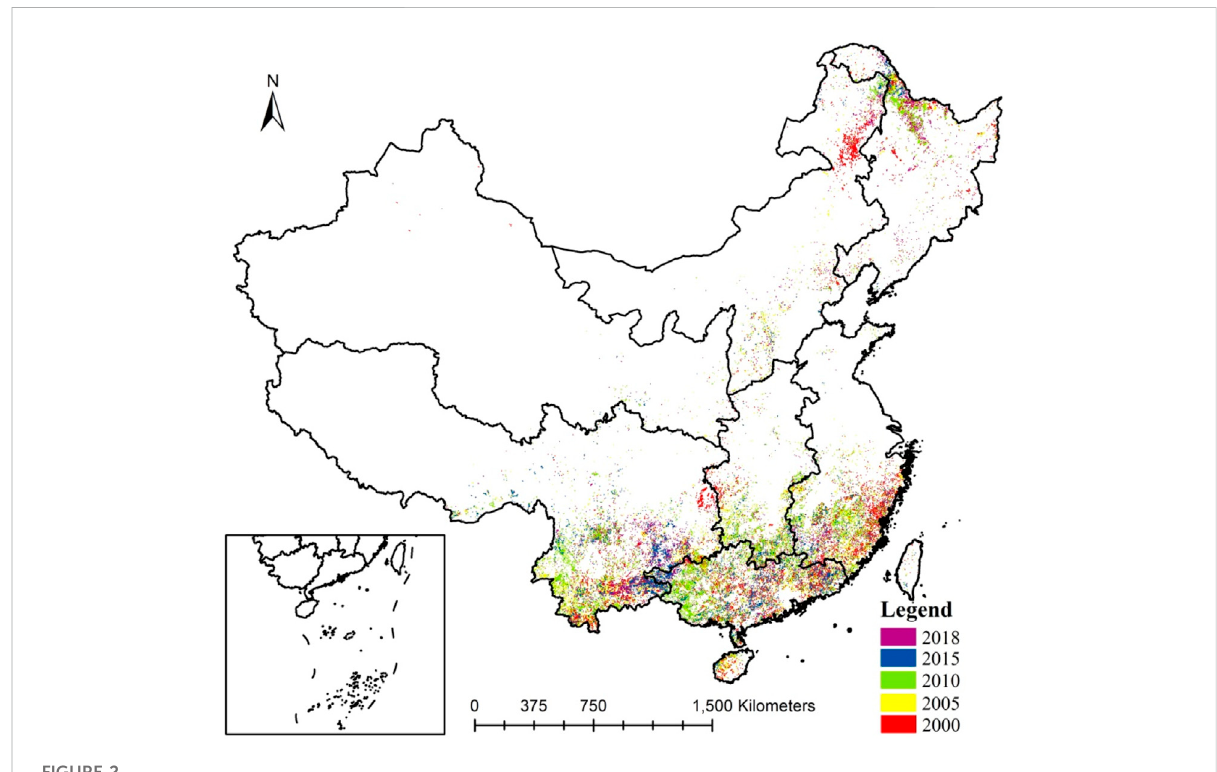
FIGURE 2 Burned area of vegetation fi re from 2000 to